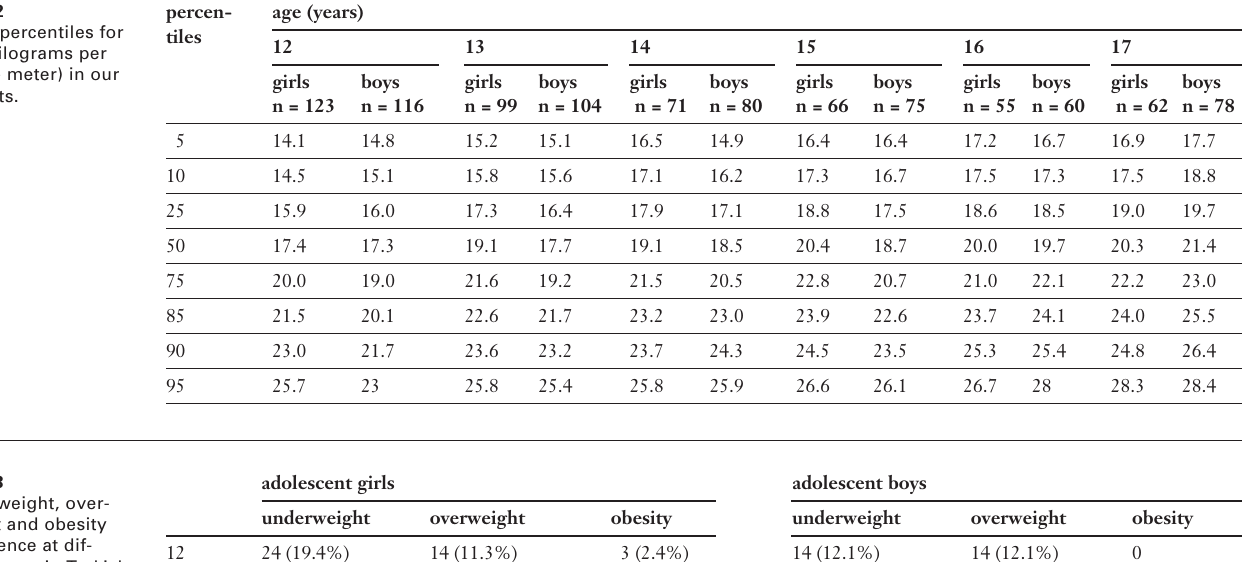
Table 3 Underweight, over- weight and obesity prevalence at dif- ferent ages in Turkish adolescents.